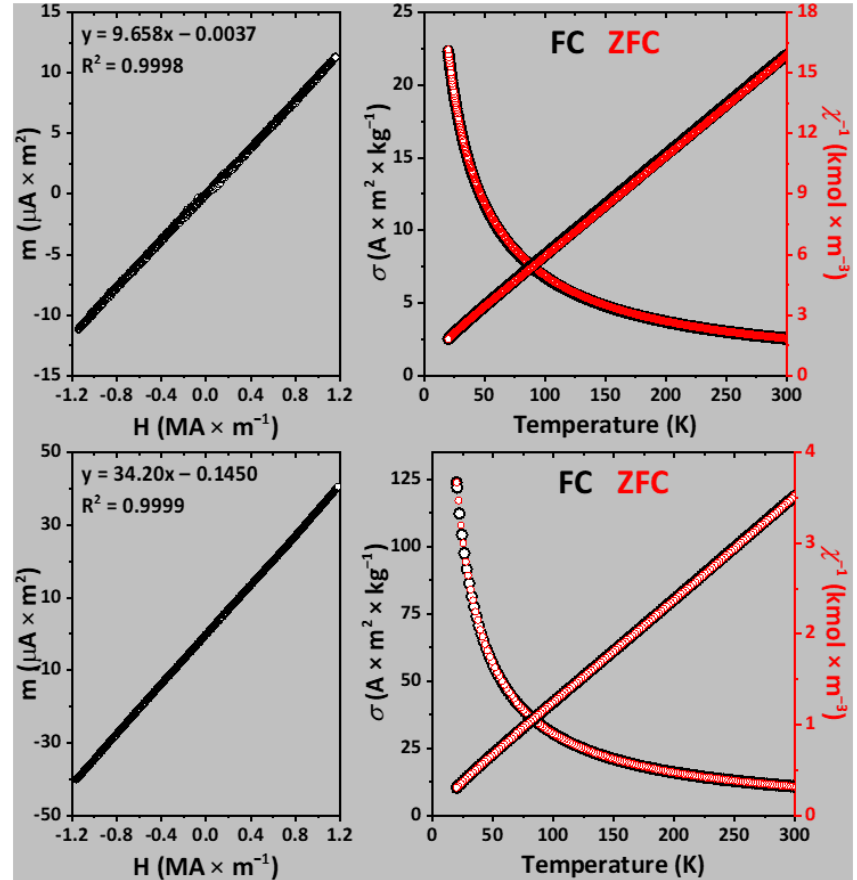
Figure 3. The normalized Kubelka – Munk spectra of SrLaCuS 3 (black), SrNdCuS 3 (red) and SrTmCuS 3 (blue). Sharp bands at about 1.30 – 1.80 and 2.06 in the spectrum of SrNdCuS 3 correspond to different transitions of Nd 3+ [53].